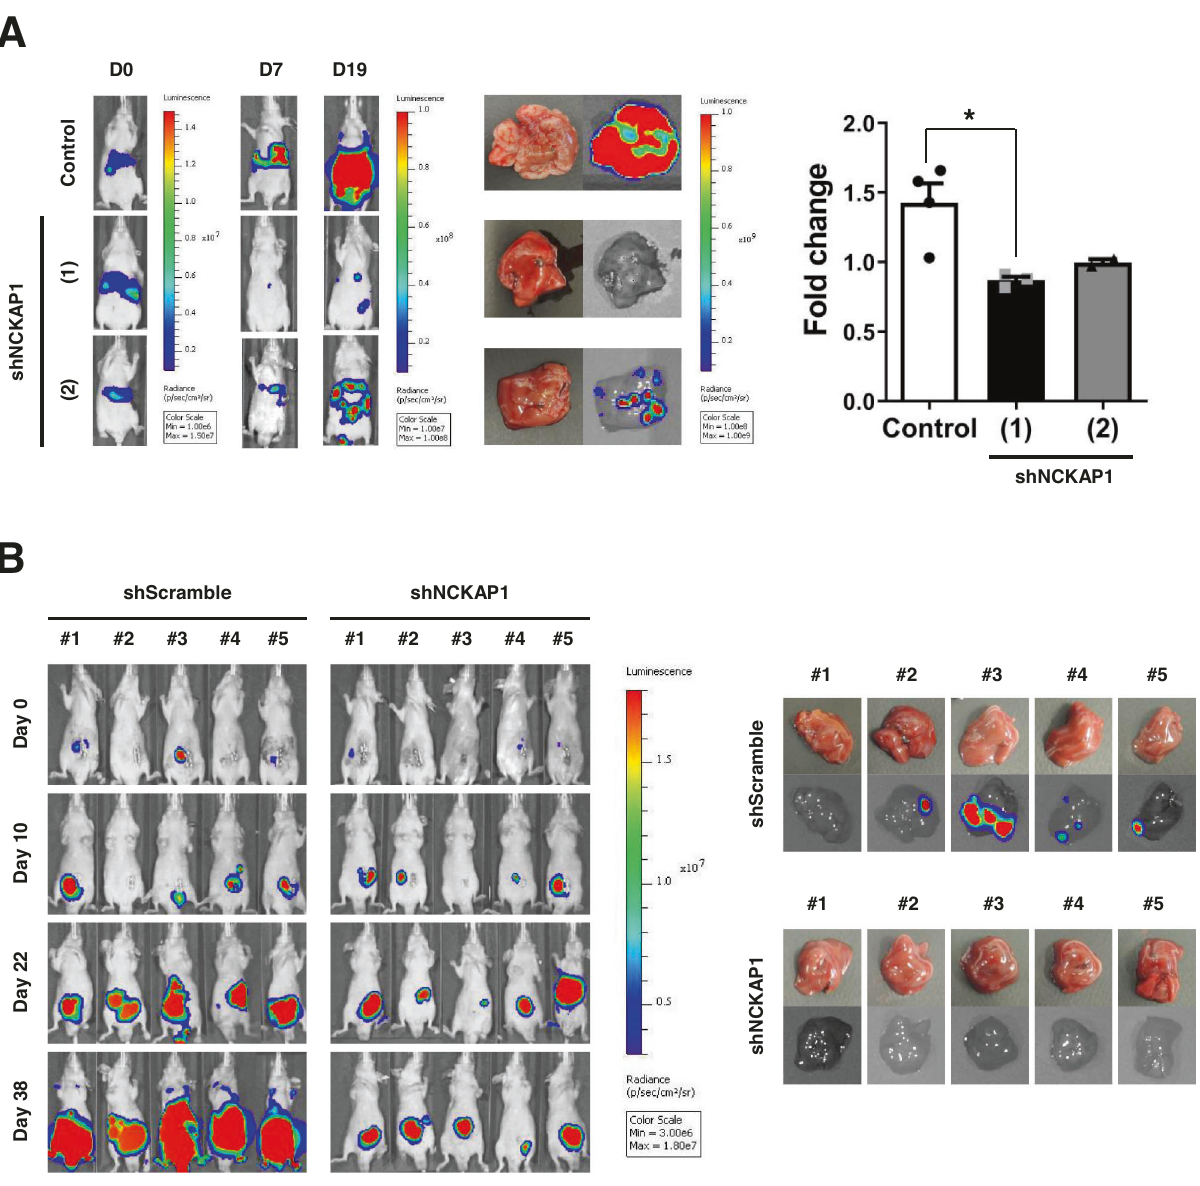
Fig. 4 Blockade of metastasis by NCKAP1 knockdown in animal models. A A liver metastasis animal model was developed via intrasplenic injection of shNCKAP1-transfected HCT116-Luc cells (5 × 10 6 cells/50 μ l), and splenectomy was performed after 5 min of circulation in BALB/c nude mice. Images of metastatic tumor growth were monitored by the IVIS ® Spectrum at 0, 7, and 19 days. Mice with metastatic livers were sacri fi ced at the endpoint of 22 days. Quantitative results on the right: the graph shows the fold change of liver weight/body weight ratio, and data are reported as the mean ± SEM. One-way ANOVA and Bonferroni ’ s post hoc test. * p < 0.05 vs. Control. (Control n = 4, shNCKAP1 (1) n = 3, shNCKAP1 (2) n = 2). B Tumor tissues for orthotopic transplantation were prepared from shScramble or shNCKAP1-transfected HCT116-Luc cells (5 × 10 6 cells/50 μ l) tumor tissues grown subcutaneously in the BALB/c nude mice. The tumor growth was monitored by for 38 days. Livers were isolated on day 38, and images of liver metastasis were measured by the IVIS ® Spectrum.